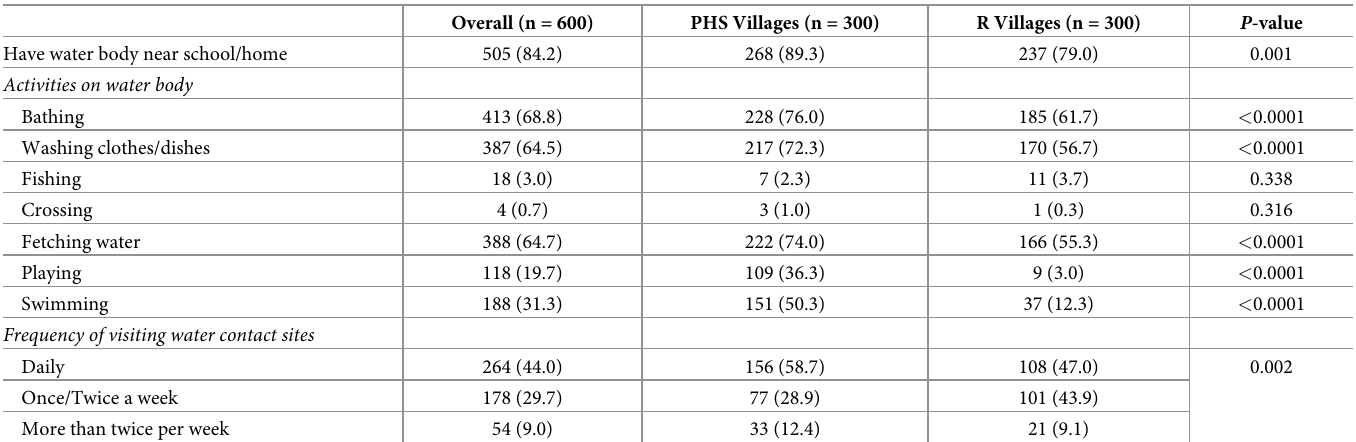
Table 11. Water contact patterns in